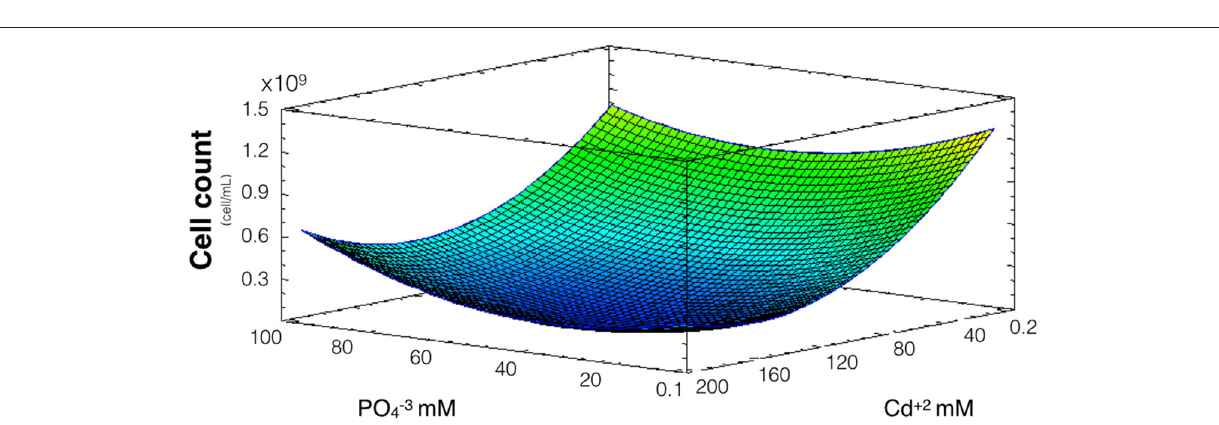
FIGURE 3 | Response surface for a two variables model describing the effect of cadmium and phosphate culture concentrations on the number of A. thiooxidans cells. ( R 2 : 68% p <